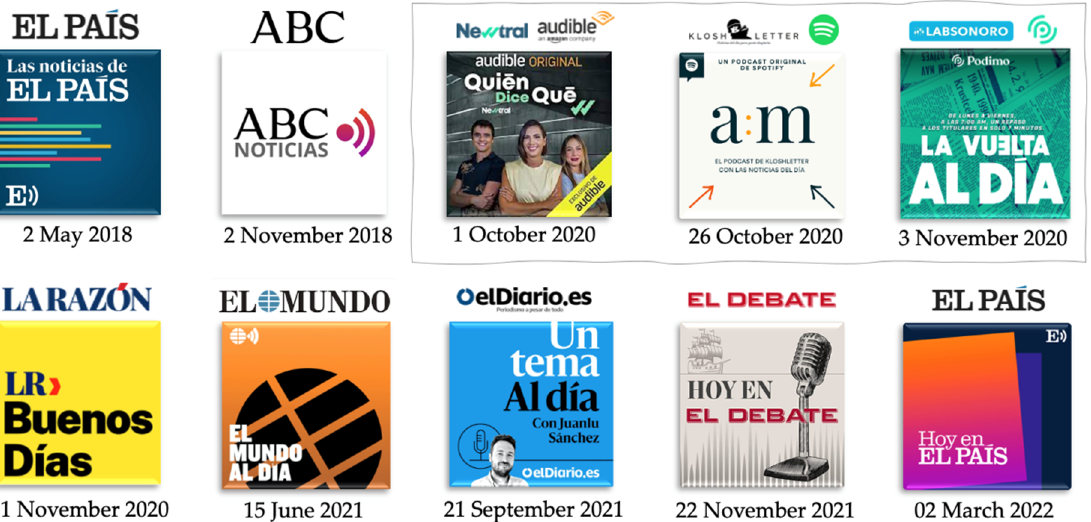
Figure 2. News podcasts of Spanish newspapers and audio platforms. Source: Prepared by the authors.